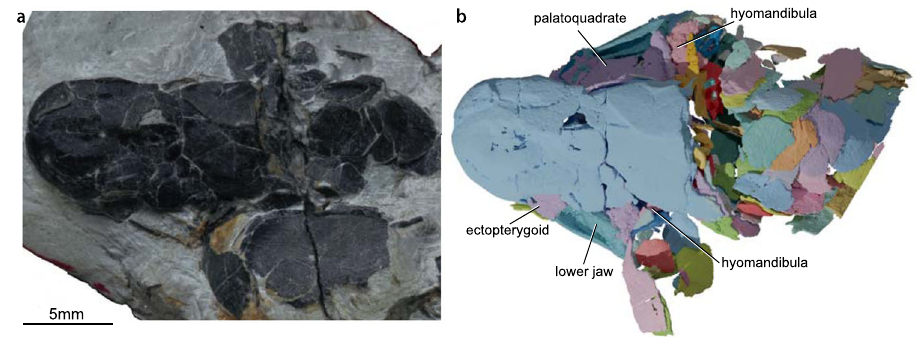
Fig. 1 Youngolepis praecursor , specimen IVPP V28375 in dorsal view. a Photograph and b virtual